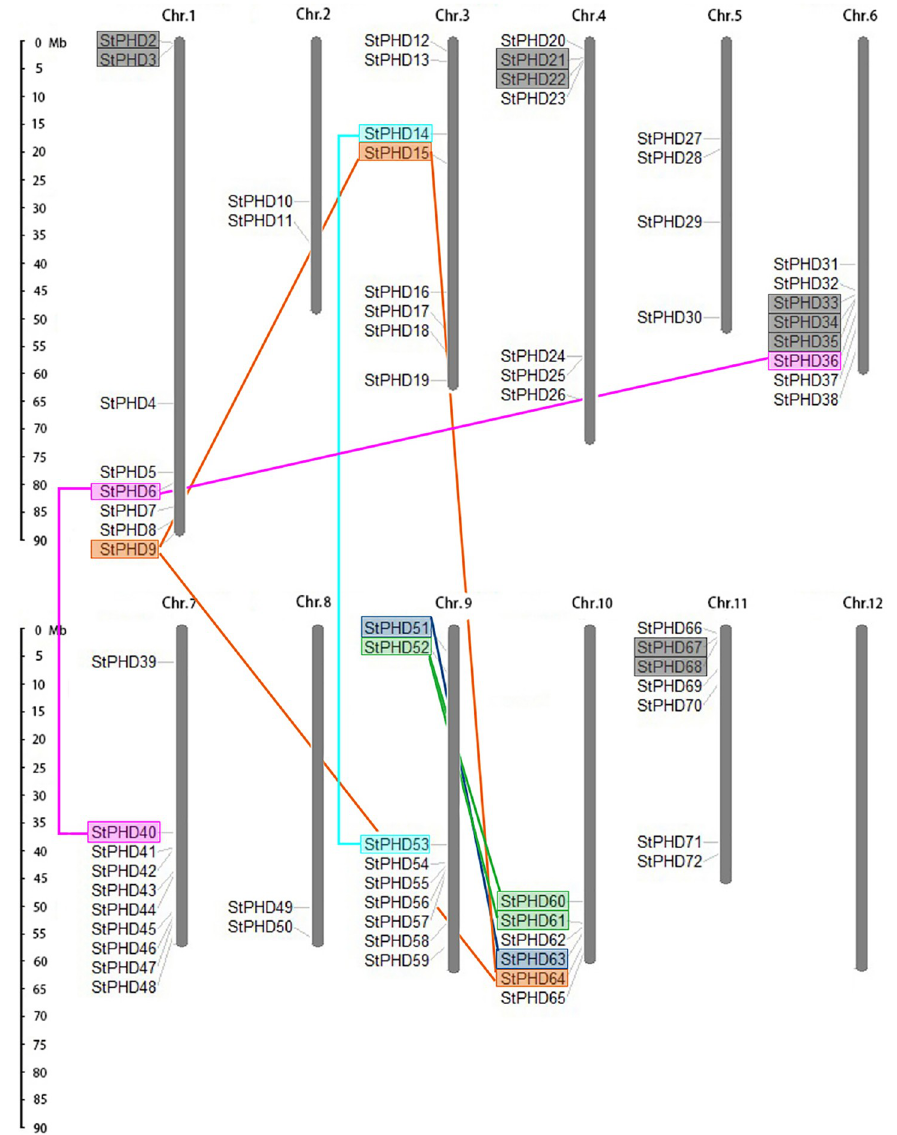
Fig 3. Chromosomal locations of potato PHD genes. The left scale represents the length of potato chromosomes (Mb). The tandem duplicated gene pairs are marked with gray boxes, and the segmental duplicated gene pairs are marked with colored boxes and are linked by corresponding color